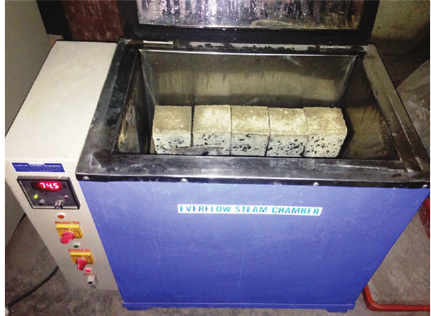
Figure 2: Geopolymer concrete specimens cured in steam chamber